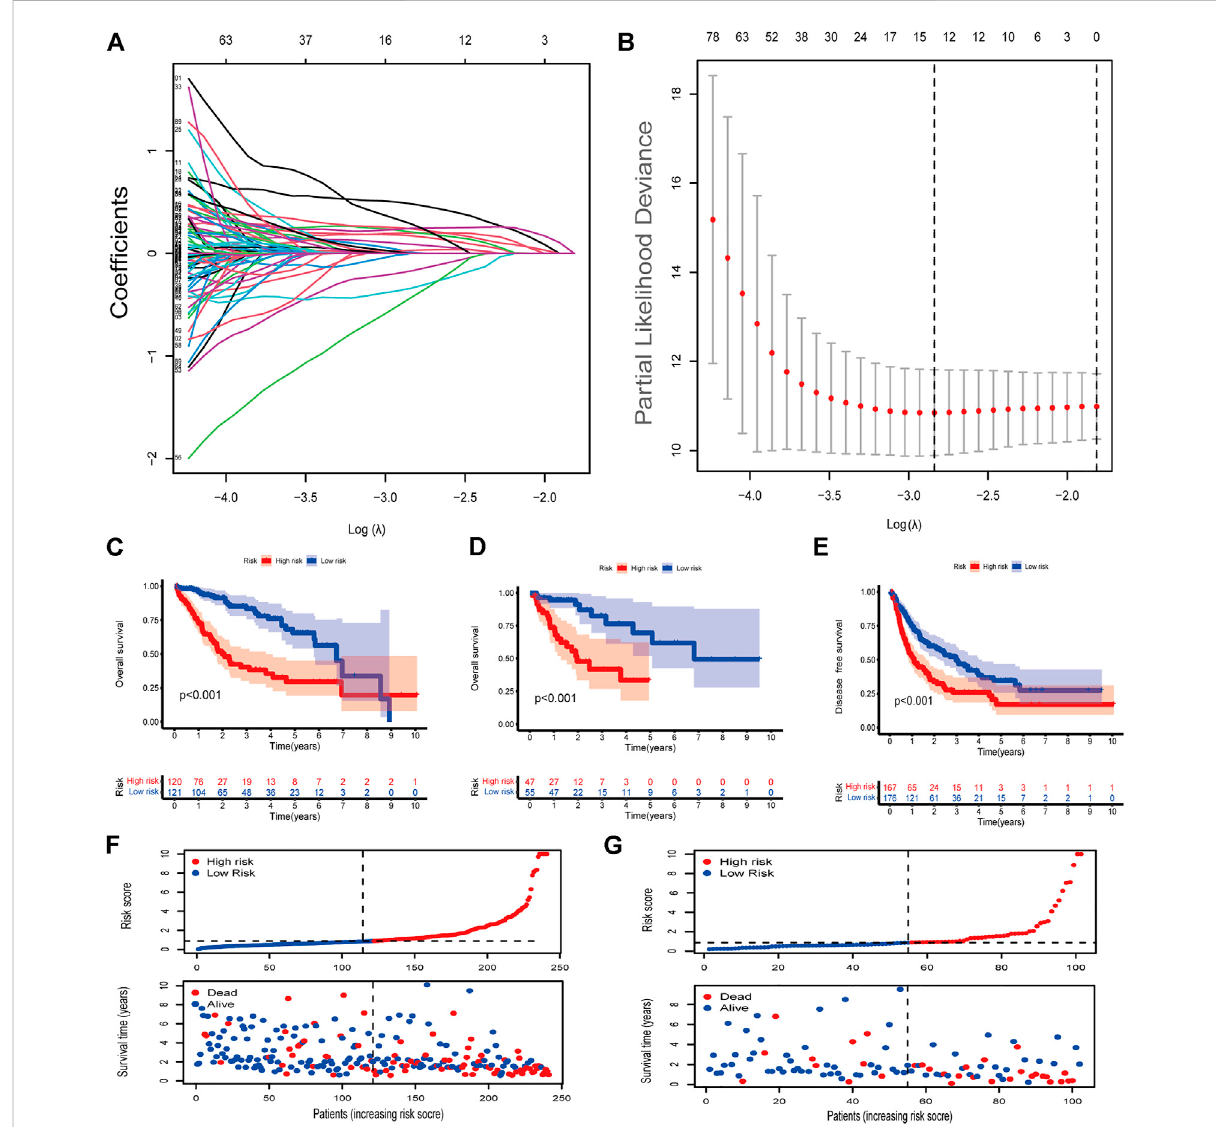
FIGURE 2 Identi fi cationofcuproptosis-associatedlncRNAswithprognosticvalueinhepatocellularcarcinoma(HCC)patients (A,B) LASSOCoxregression with a 10-fold cross-validation for the prognostic value of the cuproptosis-associated lncRNAs. (C) Kaplan-Meier analysis of the OS rate of training set patients in the high- and low-risk groups (D) Kaplan-Meier analysis of the OS rate of validation set patients in the high- and low-risk groups. (E) Kaplan-Meier analysis of the DFS rate of HCC patients in the high- and low-risk groups (F) Risk score distribution, survival status for patients in high- and low-risk groups from training set. (G) Risk score distribution, survival status for patients in high- and low-risk groups from validation